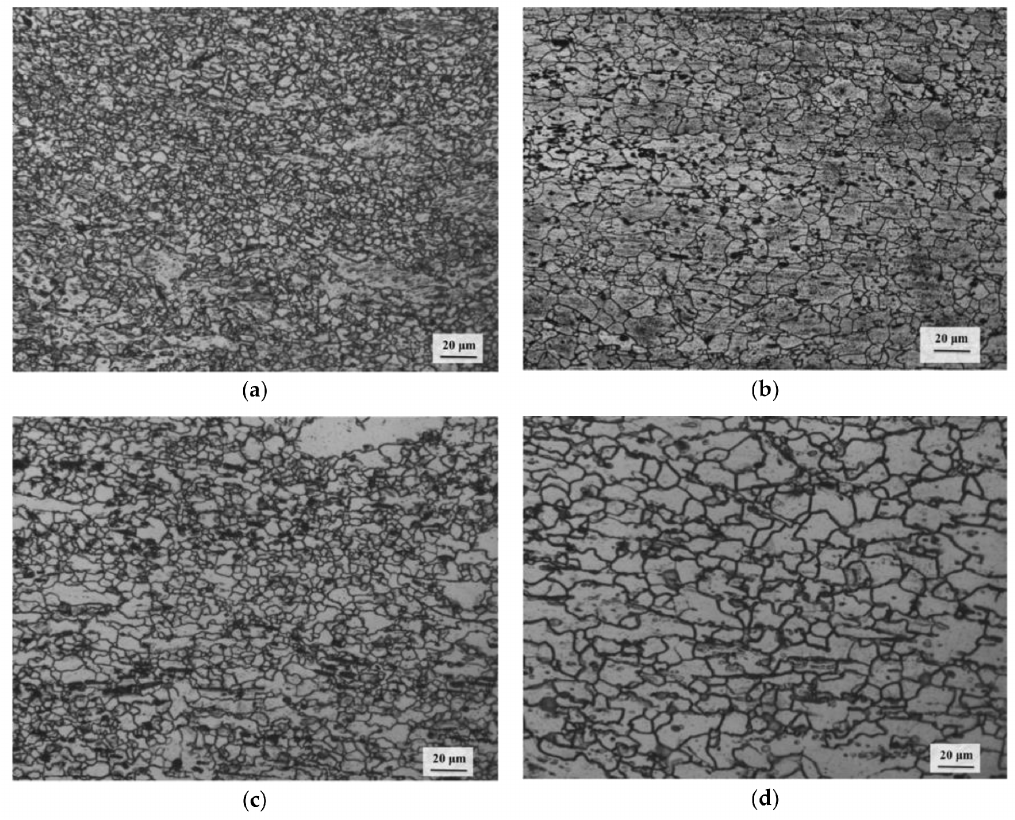
Figure 10. Optical microstructures of specimens deformed at conditions corresponding to Domain 2, revealing dynamic recrystallization (DRX) features. The compression axis is vertical. ( a ) 400 ◦ C and 0.1 s − 1 ; ( b ) 450 ◦ C and 0.1 s − 1 ; ( c ) 400 ◦ C and 0.01 s − 1 ; ( d ) 450 ◦ C and 0.01 s − 1